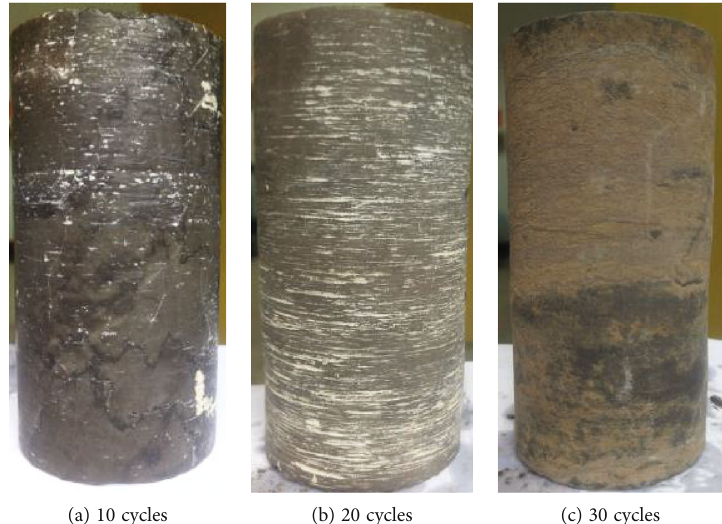
Figure 9: Change of appearance characteristics of some specimens after cyclic